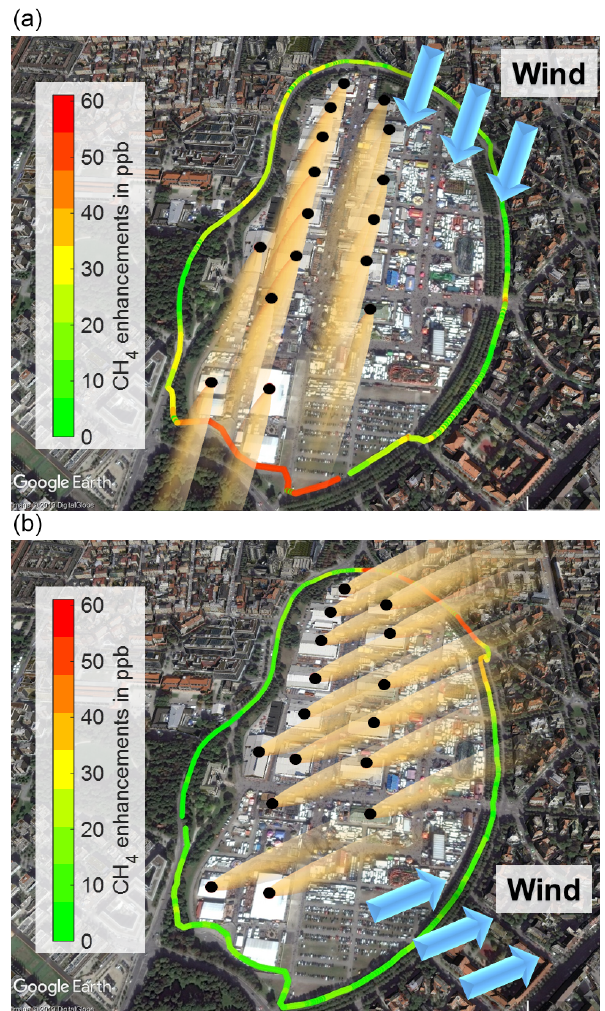
Figure 7. CH 4 concentration enhancements of two measurement rounds including the influence of the 16 Gaussian plumes from the tents (black dots). Wind direction is (a) 20 ◦ and (b) − 110 ◦ . Map data are from © Google,